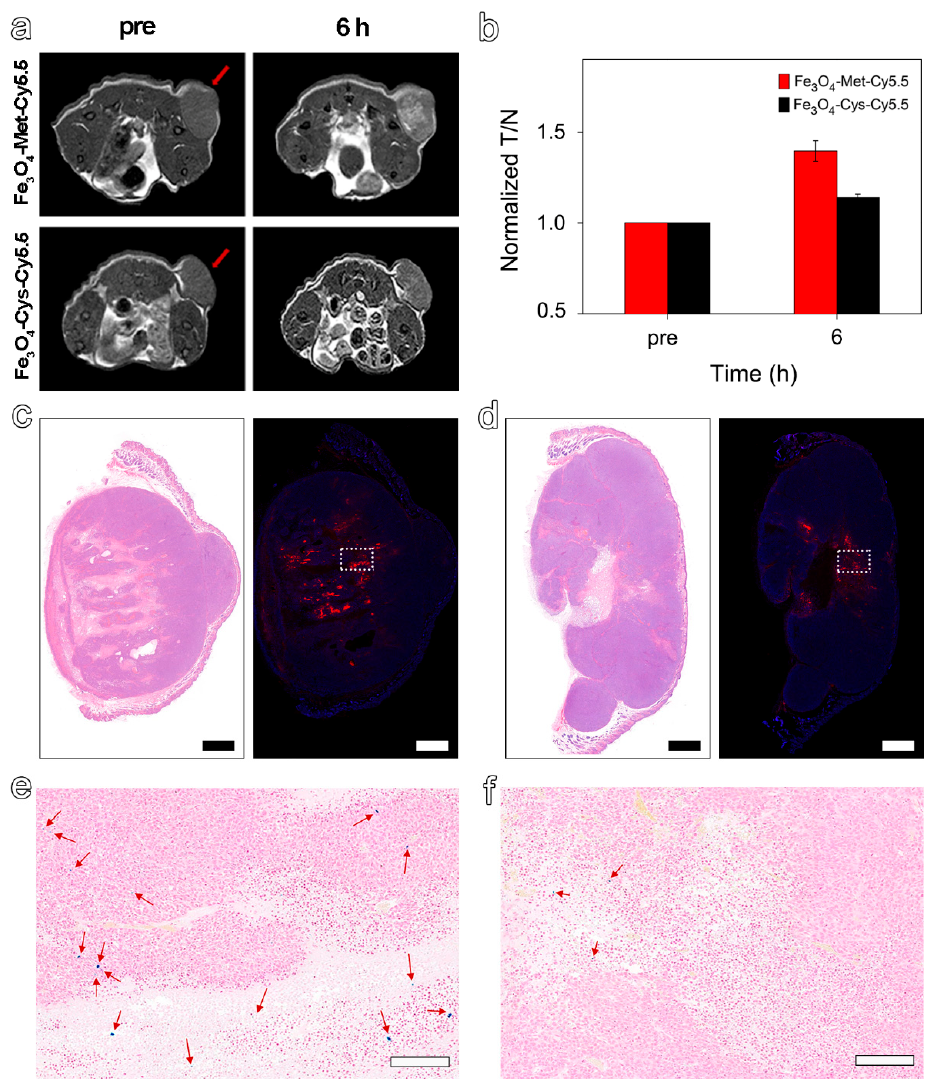
Figure 5. ( a ) T 1 -weighted MRI of tumor-bearing mice before (pre) and 6 h post-injection of Fe 3 O 4 -Met-Cy5.5 or Fe 3 O 4 -Cys-Cy5.5. ( b ) The MRI signals at the time before (pre) and after (6 h) injection of Fe 3 O 4 -Met-Cy5.5 or Fe 3 O 4 -Cys-Cy5.5. H&E staining (left) and immunofluorescence staining (right) for tumors of mice injected with Fe 3 O 4 -Met-Cy5.5 ( c ) or Fe 3 O 4 -Cys-Cy5.5 ( d ) (scale bars represent 1000 μ m). Prussian blue staining of hypoxic area (dashed area on immunofluorescence staining images) in the tumors of mice treated with Fe 3 O 4 -Met-Cy5.5 ( e ) or Fe 3 O 4 -Cys-Cy5.5 ( f ) (scale bars represent 200 μ m). 4. Conclusions In conclusion, we have successfully constructed an ultrasmall Fe 3 O 4 -based T 1 - weighted MRI probe with outstanding relaxivity performance, biocompatibility, and